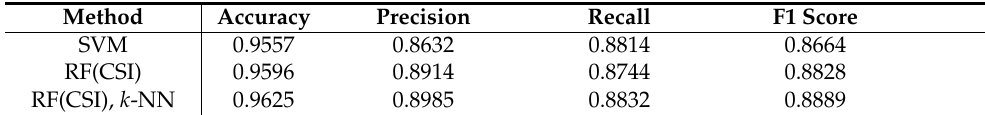
Table 6. Comparative performance of machine learning methods.